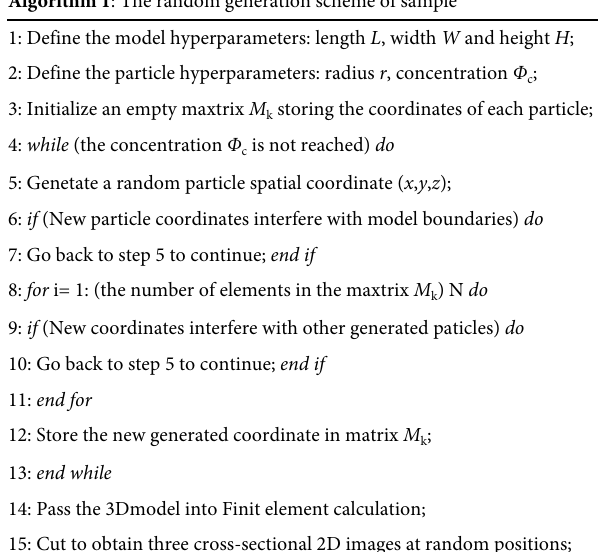
Algorithm 1 : The random generation scheme of sample